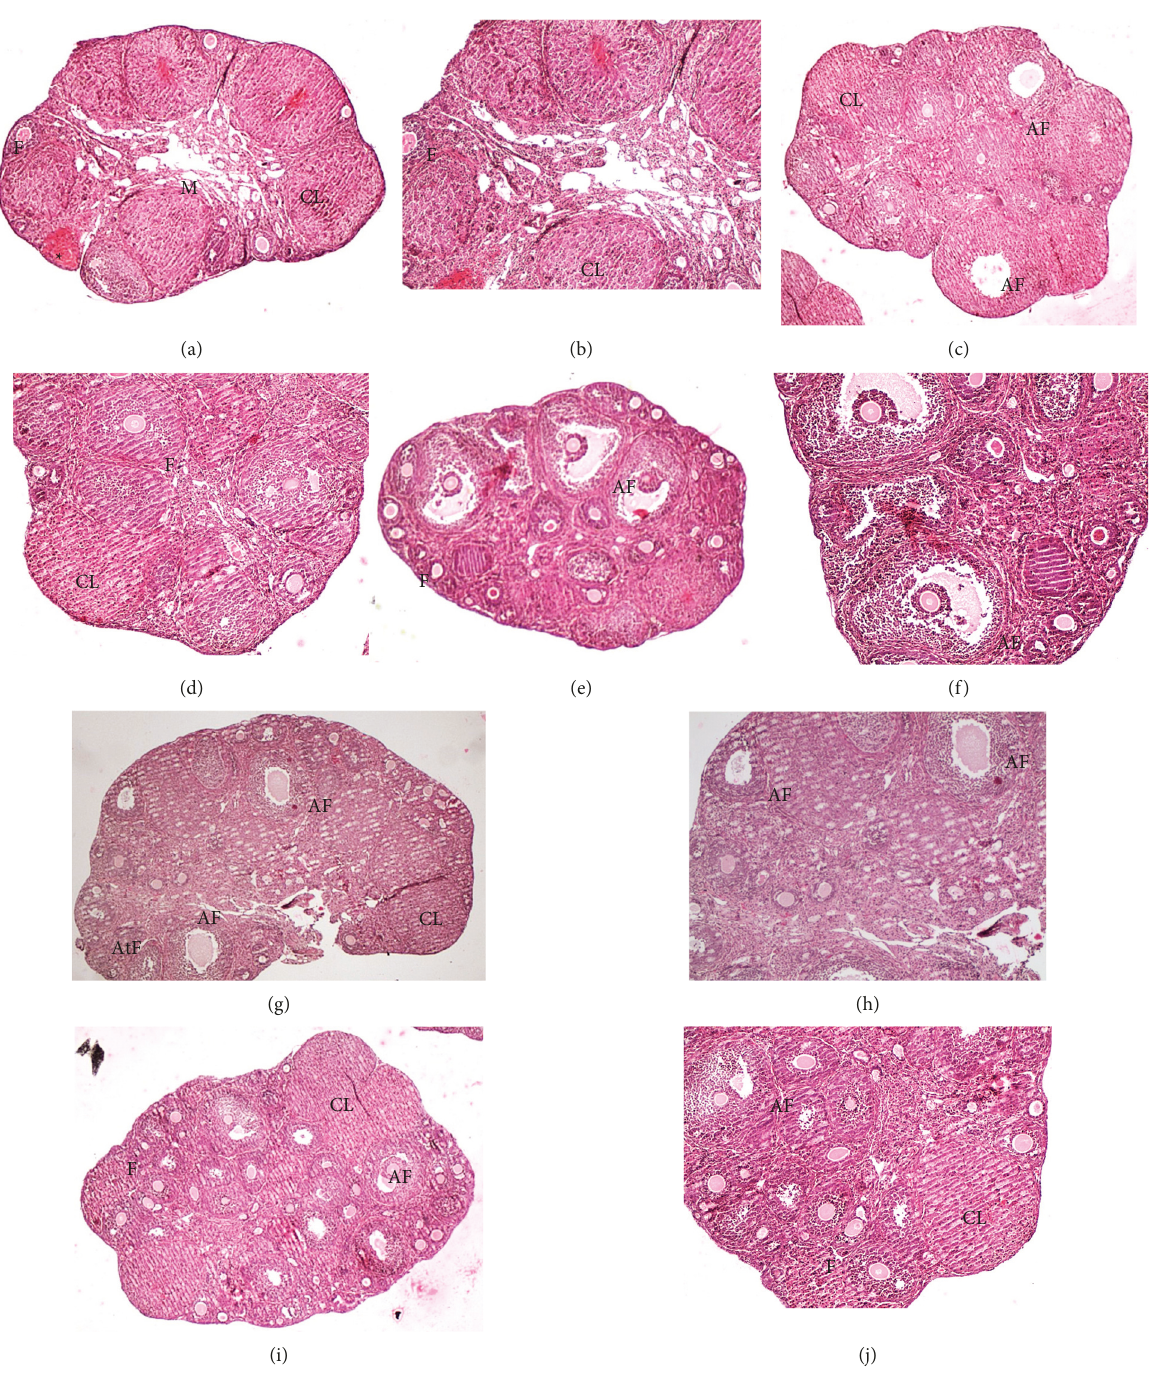
Figure 1: Photomicrographs of representative ovarian sections from the different experimental groups stained by hematoxylin and eosin. (a, b) Control group showing a spongy stroma in the medulla (M) and a cortex rich in small follicles, corpora lutea (CL), and also corpora hemorragica ( asterisk ) (40 × and 100 × magnifications). (c, d) The LS500 group with a dense cortex with numerous secondary and tertiary follicles and corpora lutea (CL) (40 × and 100 × magnifications); AF, antral follicles. (e, f) The LS1000 group showing numerous secondary and antral follicles, with visible cumulus-oocyte complexes inside the antral cavity (40 × and 100 × magnifications). (g, h) The LE500 group with growing and antral follicles (AF), corpora lutea (CL), and numerous atretic follicles (AtF) (40 × and 100 × magnifications). (i, j) LE1000 with numerous growing and antral follicles (AF) and corpora lutea (CL) (40 × and 100 ×